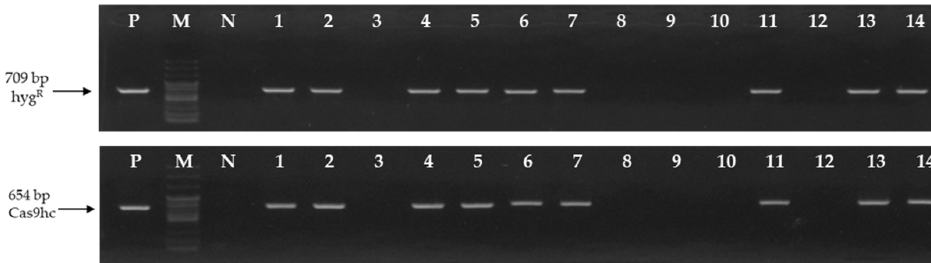
Figure 2. Identification of the tentative E 0 LFY -edited lines by polymersase chain reaction (PCR) analysis using the Hyg R and Cas9hc primer sets. The 709 bp and 654 bp PCR amplicons are indicated by an arrow, respectively. P, positive control; M, 100 bp DNA ladder; N, negative control; Numbering lane, tentative LFY -edited lines.